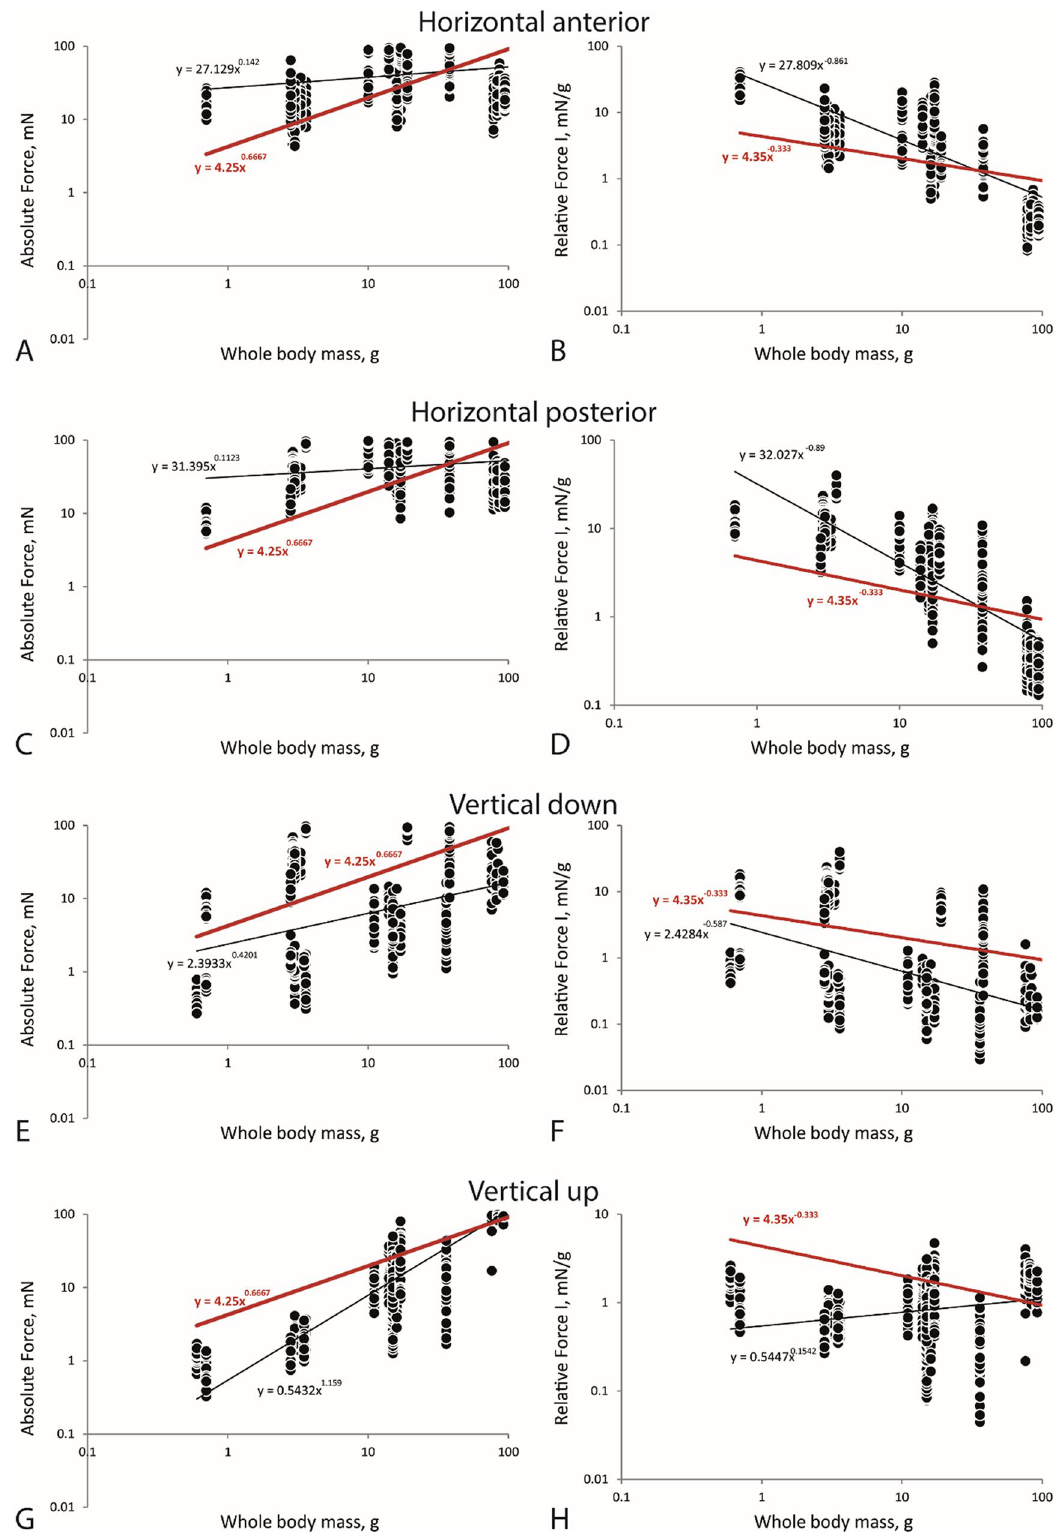
Figure 6. Linear regression, displayed on logarithmic axes, with trend lines (black = real trend line; red = calculated trend line for the factors 4.25 and 4.35), for each direction ( A – B : horizontal anterior, C – D : horizontal posterior, E – F : vertical down, G – H : vertical up). Left side ( A , C , E , G ). Variance of Absolute Force versus mean whole body mass. Right side ( B , D , F , H ). Variance of Relative Force I versus mean whole body